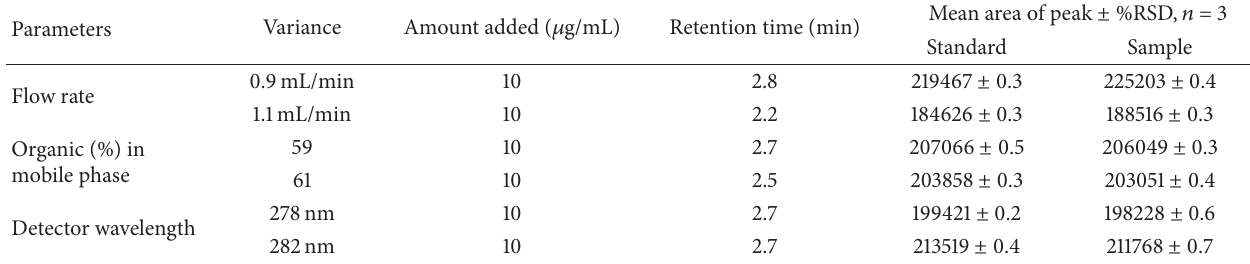
Table 6: Robustness of the